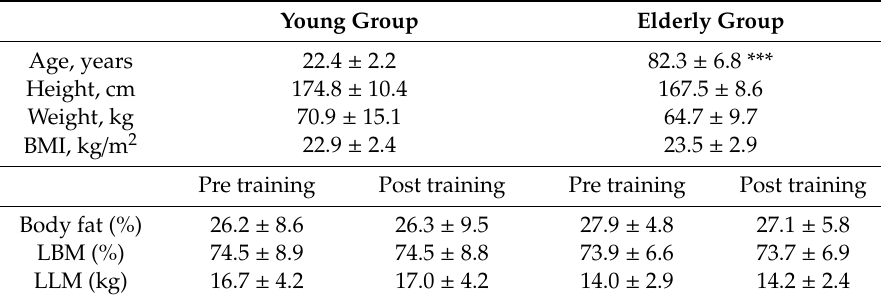
Table 1. General demographic